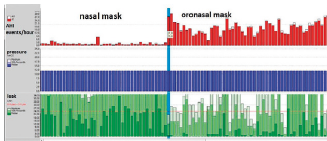
Figure 5: A screenshot from a ResScan program (ResMed, San Diego, California, USA) showing 2months of CPAP therapy with a fixed pressure at 12cm H 2 O. To reduce leaks, the nasal mask was switched to an oronasal mask, which led to a decrease in leak values (dark green) but to an increase in AHI (red and white). Oronasal masks require effectively higher CPAP pressures than nasal